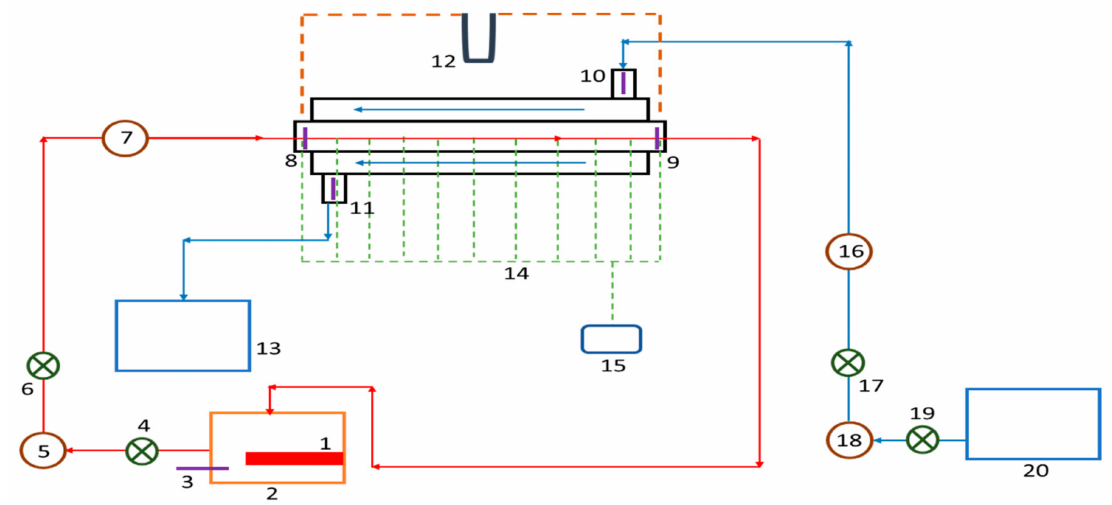
Figure 1. Experiment Set-up. 1. Heater 2. Hot water tank 3. RTD-hot water in tank 4. Ball valve